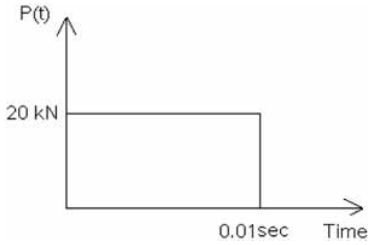
Fig. 13. Step loading for simply supported